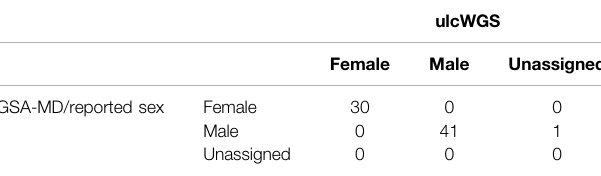
Note.ThediagonalcellsrepresentconcordanceinseximputationbetweenulcWGSand GSA-MD/reported sex. While ulcWGS was not able to impute sex for one male sample, this platform was able to correctly impute sex information for all other study populations ( ∼